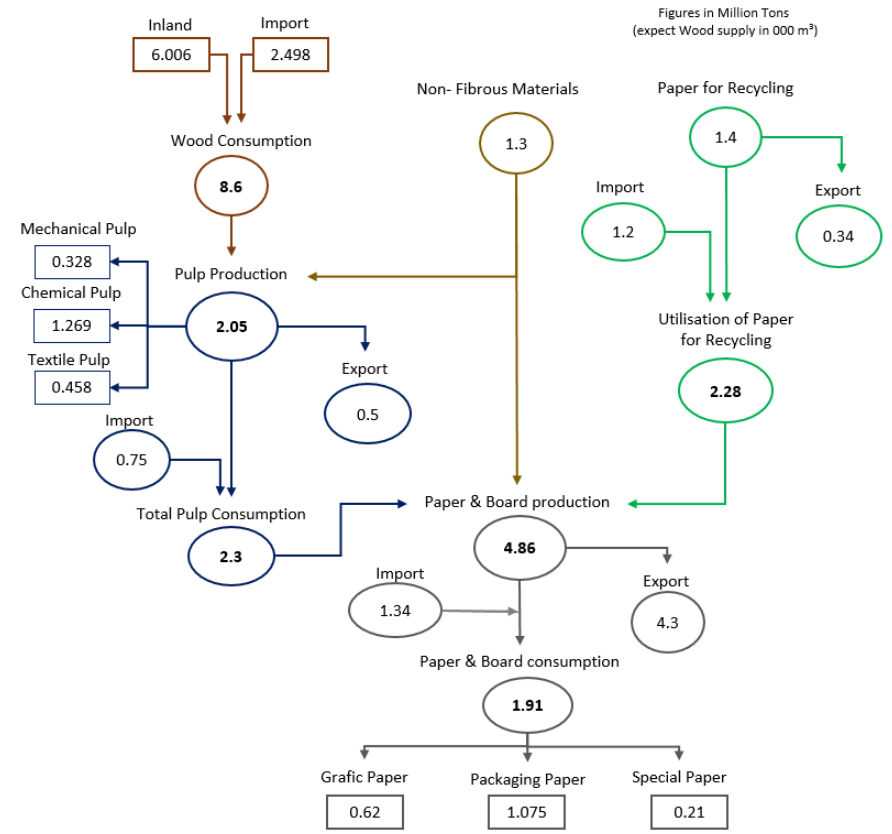
Figure 2. Material flow in the Austrian pulp and paper sector in the year 2017 [9], illustration inspired by CEPI (Confederation of European Paper Industries) [23].